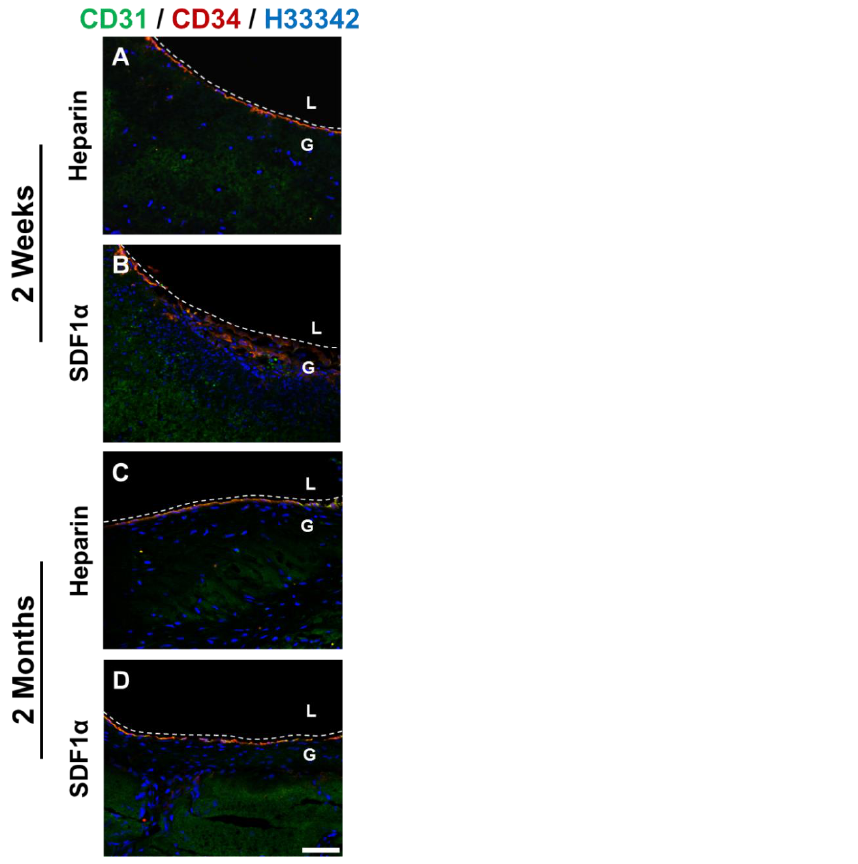
Figure 11. Immunostaining for CD 31 ( green ) and CD34 ( red ) of the cross-section of heparinized and SDF-1 α immobilized grafts at ( A, B ) 2 weeks and ( C, D ) 2 months after implantation. Nuclei were stained with Hoechst 33342 ( blue ). Dashed lines are used to distinguish the boundaries between L (lumen), and G (graft). Scale bar = 50 µ